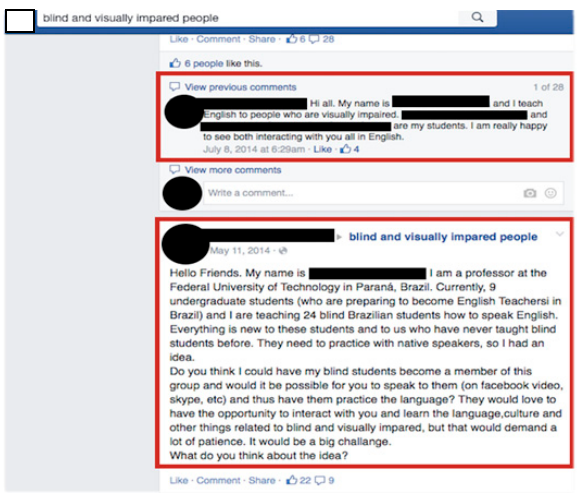
Figure 1. Professor/researcher asking if students could become members of a group. Retrieved from [44] with permission.